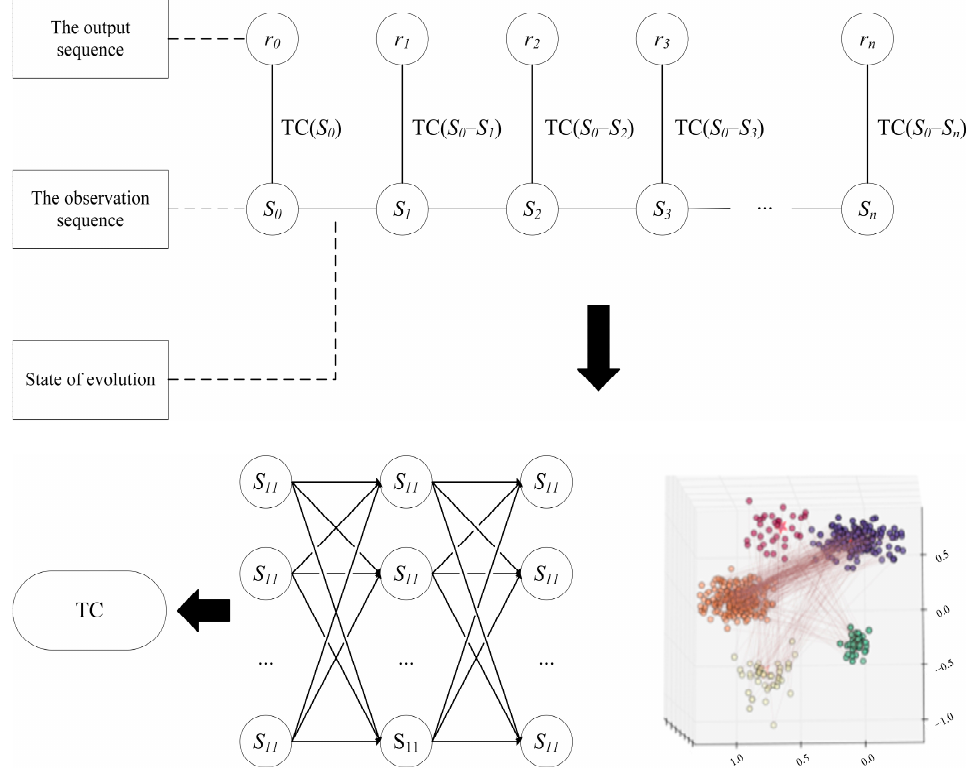
Figure 5. Conditional random field undirected graph